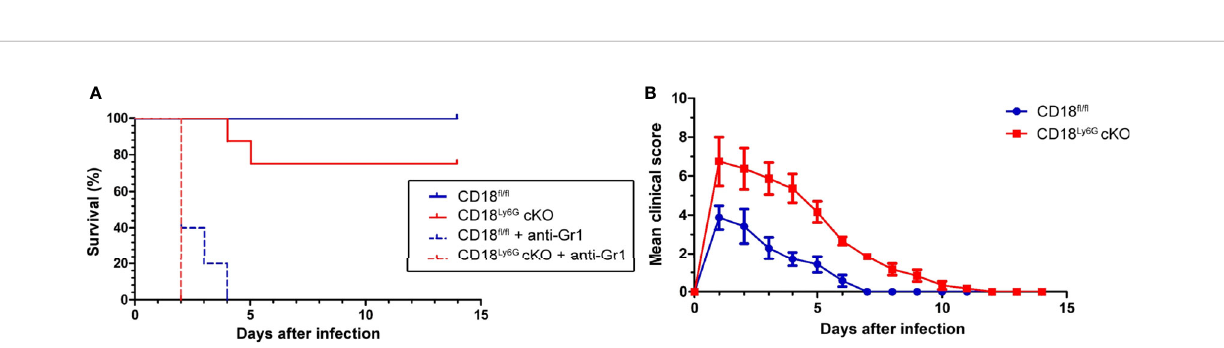
FIGURE 2 | Infection with IPA caused an impaired survival (A) and an aggravated course of the disease (B) in CD18 Ly6G cKO as compared to CD18 fl / fl mice. CD18 fl / fl and CD18 Ly6G cKO mice were infected i.t. with A fumigatus (each 10 7 conidia/mouse) in 2 independent experiments. (A) Survival was monitored daily for 2 weeks and is presented in a Kaplan-Meier survival curve. In parallel settings PMN were depleted in some mice via injection of an anti-Gr-1 antibody one day before infection. Data show the cumulative results of two independent experiments with a total of 12 (CD18 fl / fl ) and 13 (CD18 Ly6G cKO) mice/group. 5 mice/group received an anti-Gr-1 antibody in order to deplete PMN in these mice. All Gr-1 depleted mice died within the fi rst days after IPA infection, whereas all non-depleted CD18 fl / fl mice survived. By contrast, some non-depleted CD18 Ly6G cKO mice (n=2) deceased within the fi rst week after IPA infection. (B) The clinical course of IPA of monitoring was assessed in CD18 fl / fl (n=7) and CD18 Ly6G cKO mice (n=8) for 14 days. Parameters comprised breathing, reaction to pain overall appearance, hypothermia, strong weight loss, motoric disabilities and apathy (each